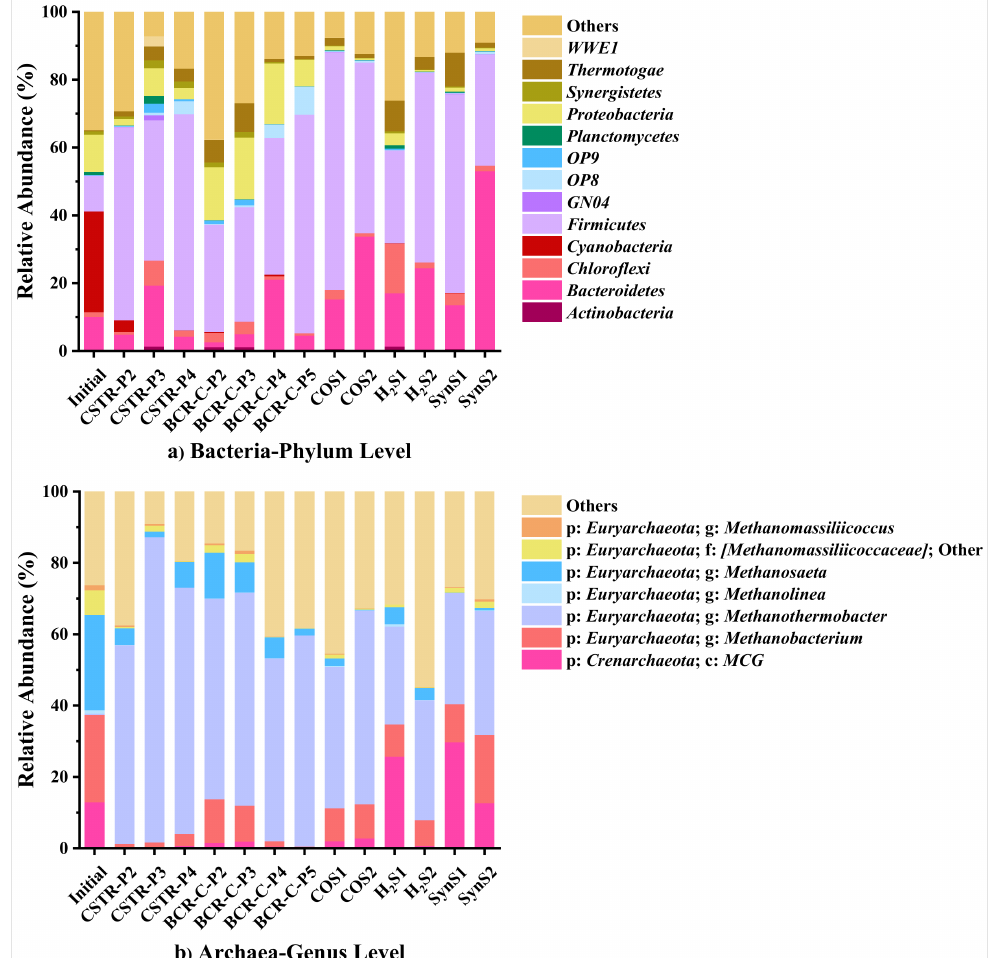
Figure 10. Relative abundance of ( a ) Bacteria at the phylum level and ( b ) Archaea at the genus level using V4-V5 region primer set (Initial: anaerobic granular sludges before inoculation. P2-5: Periods II-V of different test runs. Others: the sum of all genera/phyla with the relative abundance below 3% in the individual